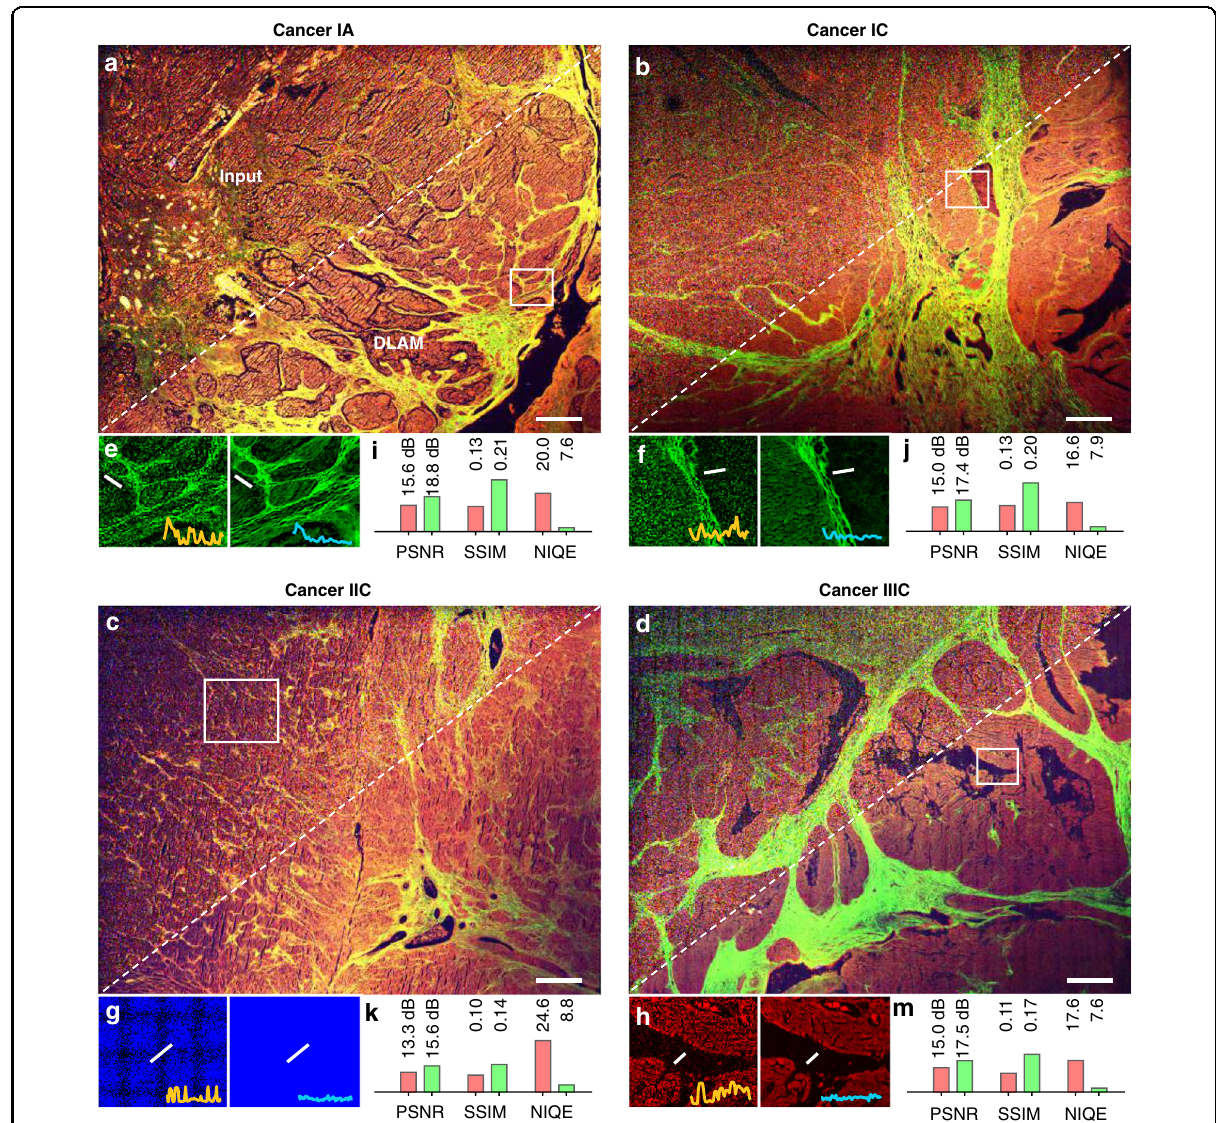
Fig. 3 Label-free multimodal nonlinear images of human ovarian carcinomas. a – d Full view of the large fi eld (5.4 × 5.4 mm 2 ) at FIGO Stage IA, IC, IIC, and IIIC, with the white dashed lines separating the registered input (top left) and the network output (bottom right). White squares indicate ROIs magni fi ed in ( e ) – ( h ) (left: input, right: output) for the highest metric enhancement. The white solid line in each inset image refers to the line of the shown cross-section. i – m Quality metrics for the input (pink) and output (pale green) large images are compared in the histograms. Scale bars, 500 μ